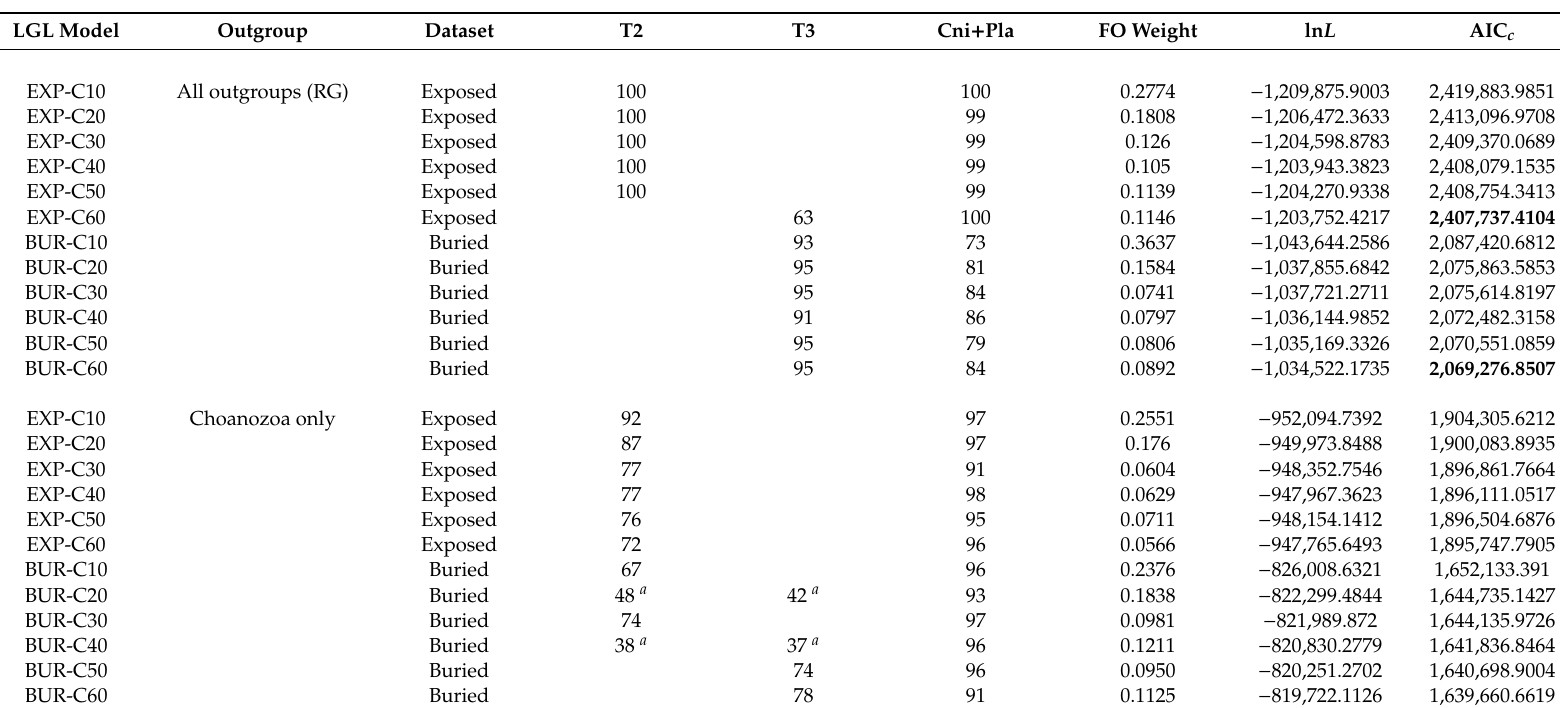
Table 4. Log likelihood and AIC c scores for various LGL-BUR and LGL-EXP models. The best-fit model is indicated in bold and the FO mixture weight is